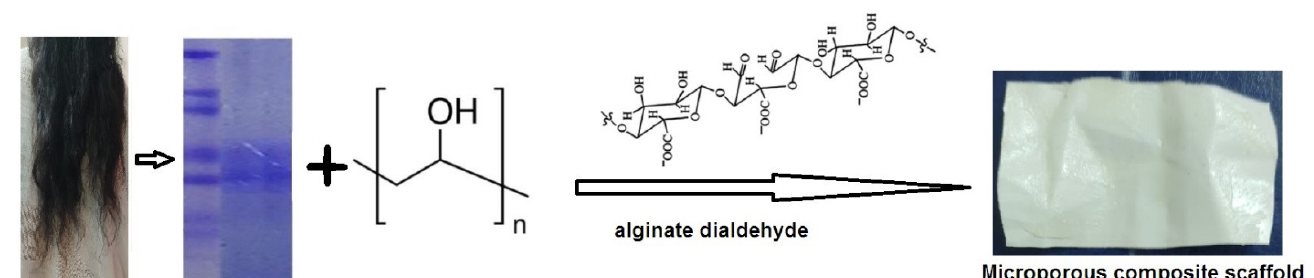
Figure 8. Schematic representation of human hair keratin scaffold fabrication.